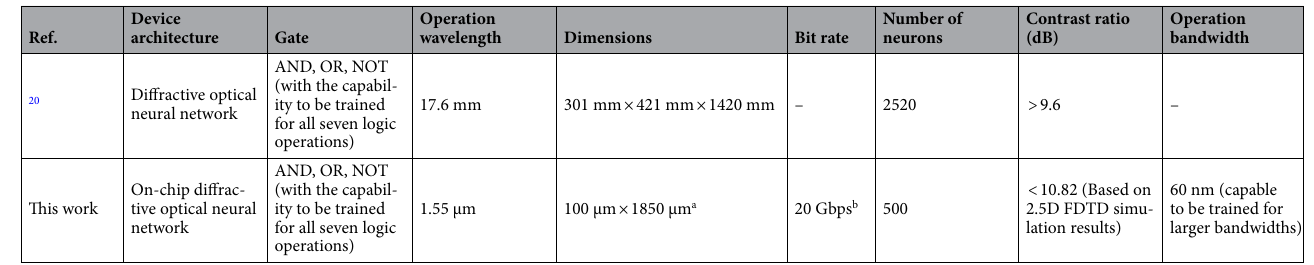
Table 3. Comparison between our design and the multifunctional optical logic gate based on DONN presented in 20 . a For a brief discussion on the size of the device, please refer to supplementary note 3. b Due to low latency (~ 18.3 ps) and fast response of our design 34 , state-of-the-art high-speed photodetectors with up to 50 GHz photodetection rate are applicable to our architecture. By assuming 20 GHz photodetection rate, the bit rate of our design, will be 20Gbps. For a brief discussion on the possible photodetection schemes, please refer to supplementary note